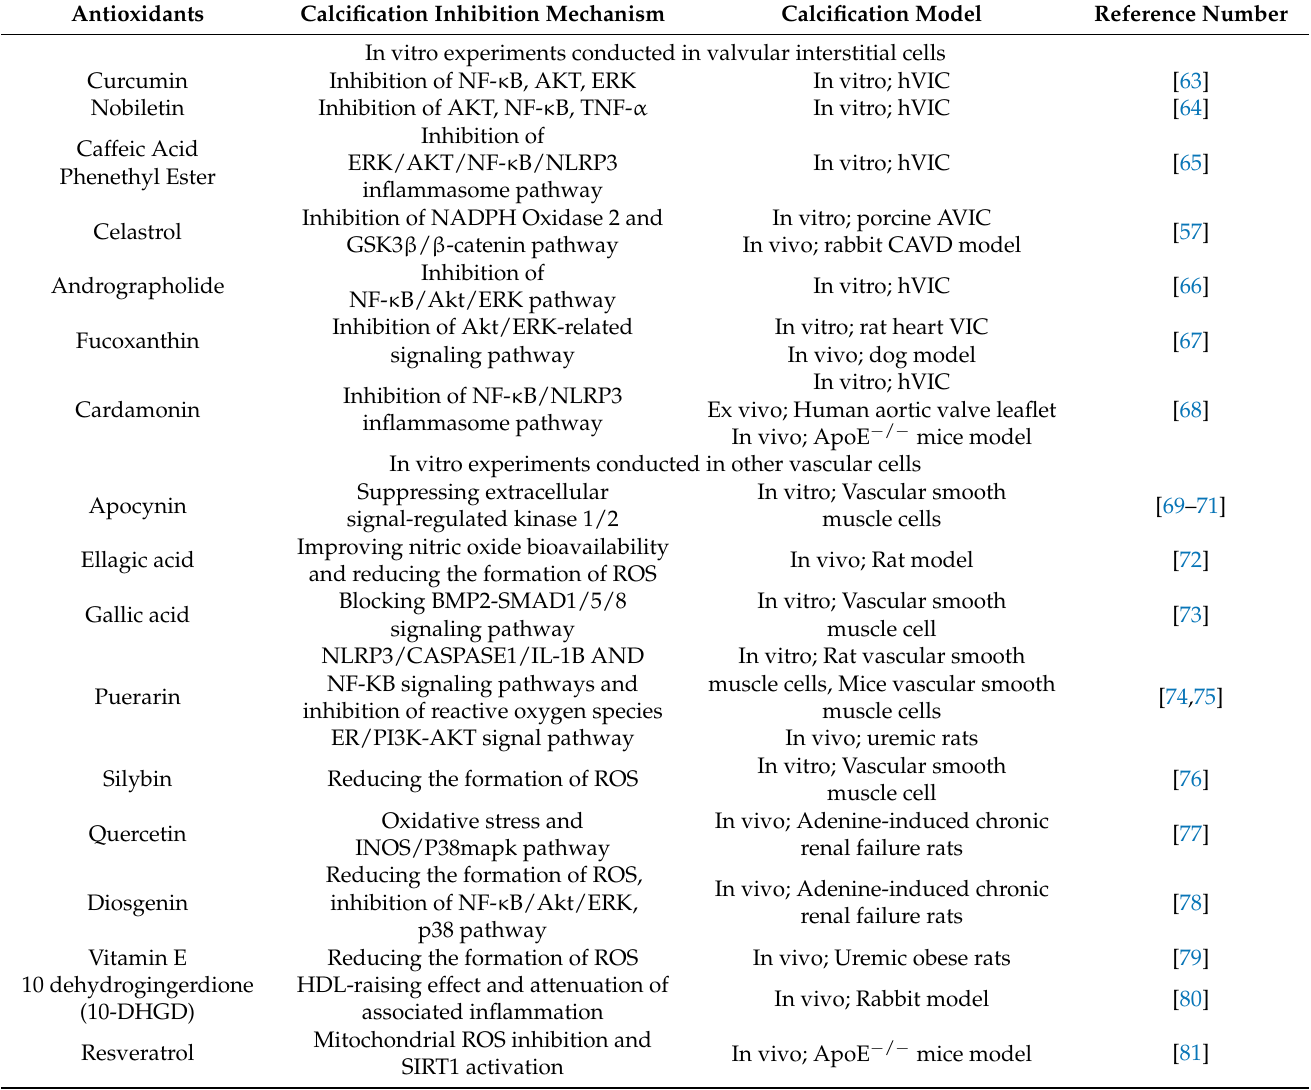
Table 1. The list of antioxidants with their preventive role in